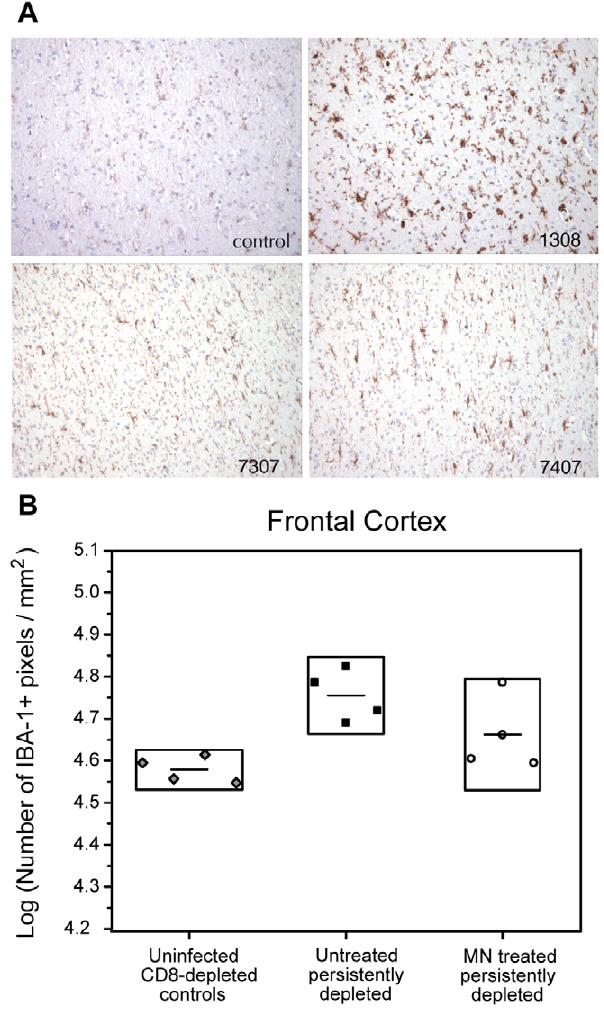
Figure 7. Minocycline reduces microglial activation, assessed by ionized calcium binding adaptor molecule 1 (IBA-1) expression. ( A ) IBA-1 expression in four representative sections from each of an uninfected, CD8-depleted animal ( control ), an untreated SIV-infected CD8-depleted animal ( 1308 ), a MN-treated persistently CD8-depleted animal ( 7307 ) and a MN-treated short-term CD8- depleted animal (7407). Visual inspection reveals less IBA-1 expression in the MN-treated animals. ( B ) Immunohistochemistry image analysis for IBA-1 in brain tissue sections of the frontal cortex. Data is given for four uninfected, CD8-depleted animals which served as controls (diamonds), four untreated SIV-infected CD8-depleted animals sacri- ficed at 8 wpi (solid squares) and four minocycline (MN)-treated (persistently CD8-depleted) animals. The mean for each cohort is given as a horizontal black line within its respective box. Upper and lower boundaries of the boxes correspond to a factor of 1.5 times the standard deviation. There was a statistically significant difference in frontal cortex IBA-1 levels among the three cohorts (p=0.012). There are more IBA-1 positive particles/mm 2 in the SIV-infected, CD8- depleted, untreated cohort compared to -uninfected, CD8-depleted controls (p=0.004). There was no statistically significant difference in IBA-1 positive particles/mm 2 in MN-treated animals compared to the uninfected CD8-depleted